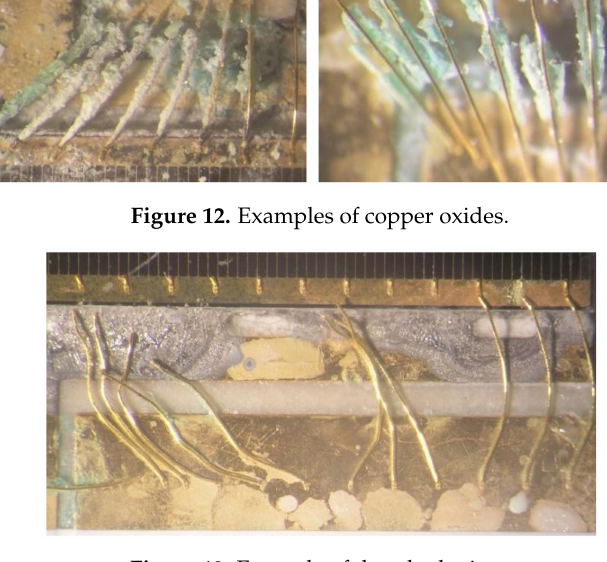
Figure 13. Example of detached